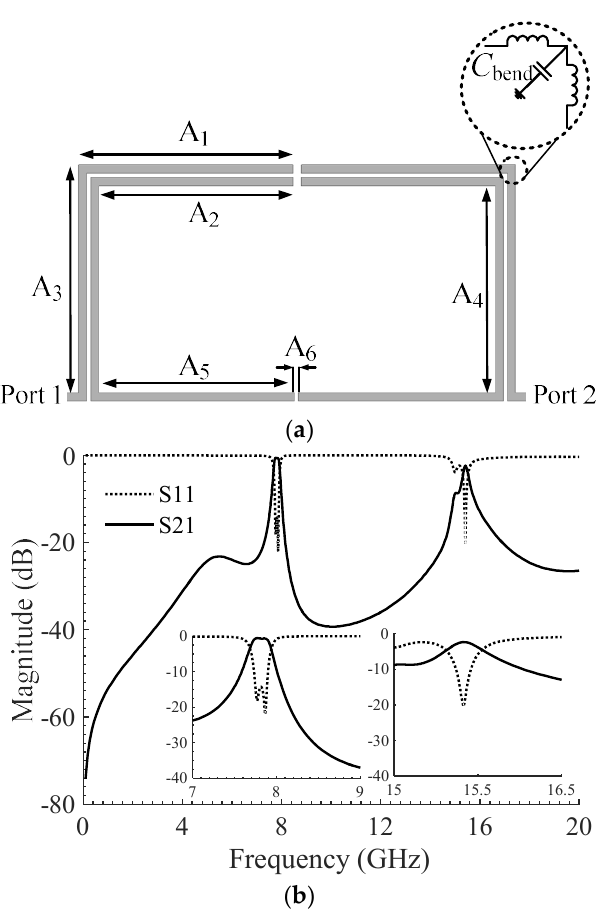
Figure 2. Bended coupling system: ( a ) Layout, A 1 = 5.3, A 2 = 4.8, A 3 = 5.6, A 4 = 5.1, A 5 = 4.8, A 6 = 0.1 (all in mm), ( b ) EM simulation.